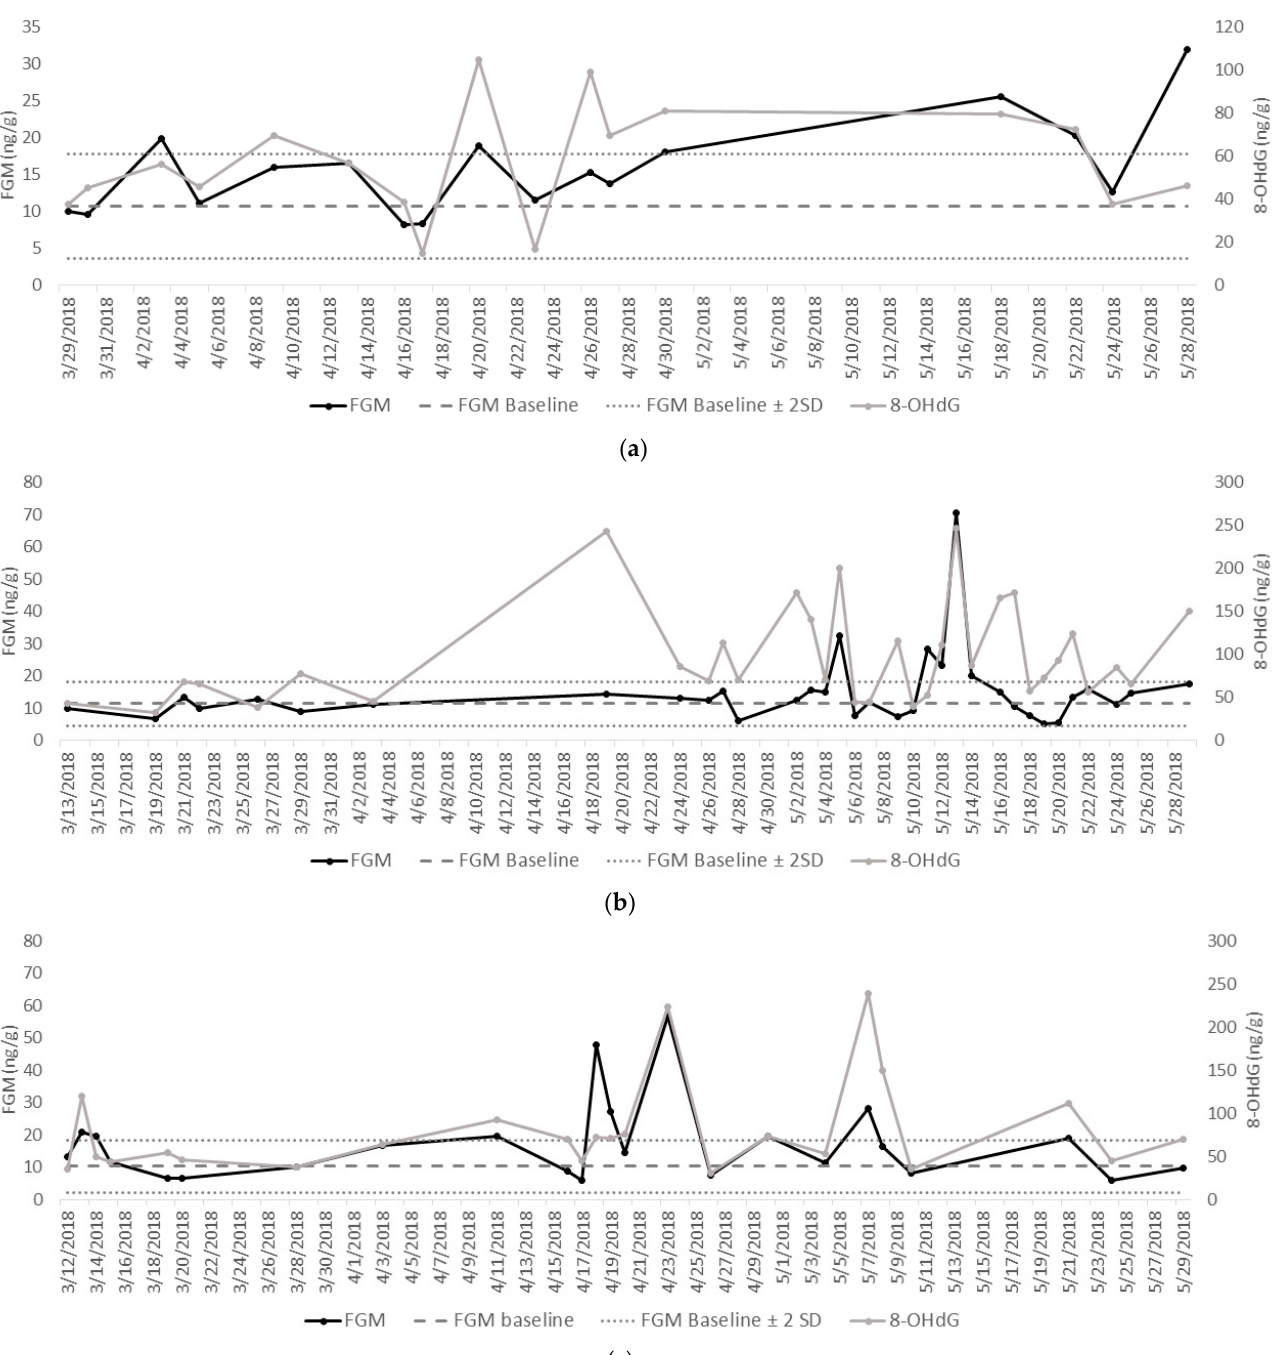
Figure 2. Longitudinal concentrations of fecal glucocorticoid metabolites (FGM) and fecal oxidized guanine (8-OHdG) in three male grizzly bears while they occupied a temporary, smaller habitat. Concentrations are expressed as ng/g dry feces. Note the different scales on the graph for Boo ( a ) compared to Mike ( b ) and Thor ( c ).